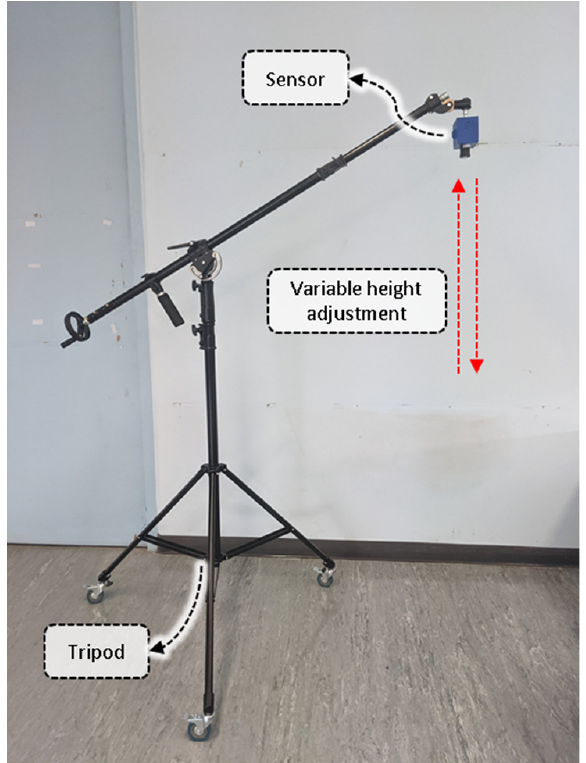
Figure 3. The laboratory distance measurement experimentation. The CropBioMass (CBM) sensor was positioned at different reference distances. The LiDAR measurement response was empirically